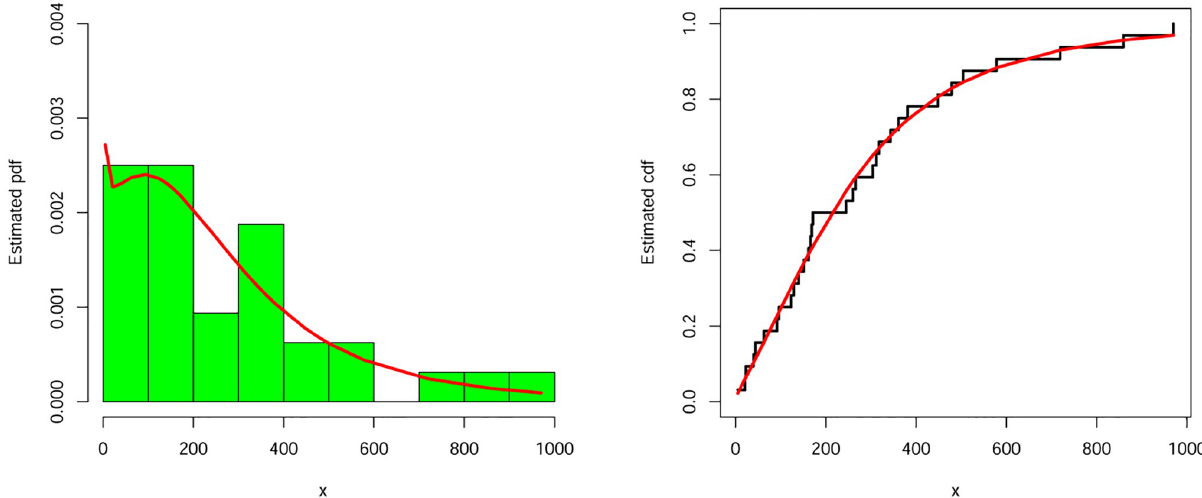
Fig 7. Estimated density and distribution functions of the NEHTW distribution for vehicle insurance losses data.